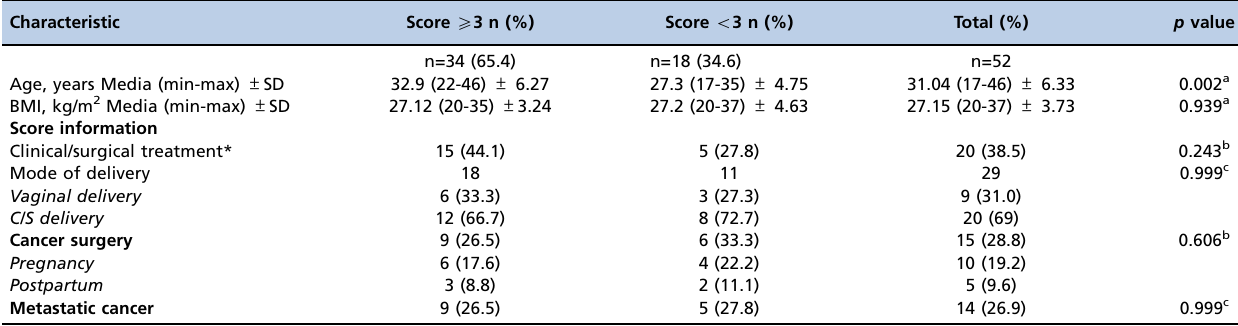
Table 2 - Demographic and delivery characteristics of pregnant women at low and high risk of venous thromboembolism during hospitalization (HC-FMUSP, 2016). Characteristic